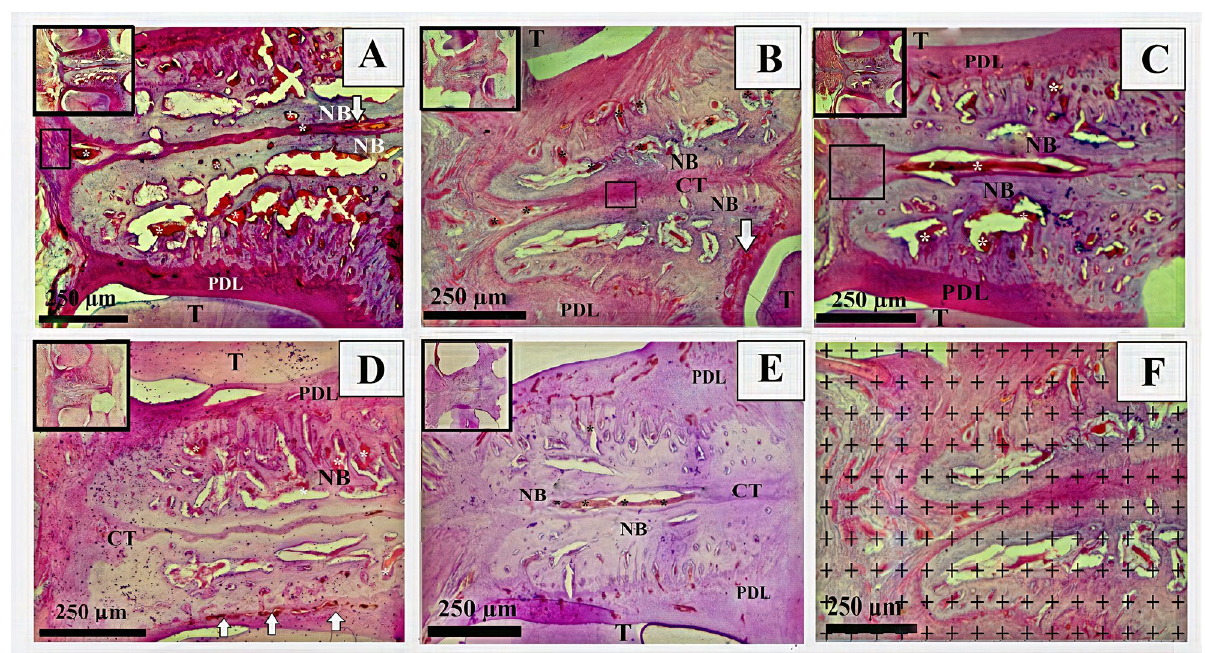
Figure 5. Histological representative light microscopic images of the groups ( A ) F2, ( B ) F1, ( C ) U2, ( D ) U1, ( E ): C and the point counting grid for Cavalieri volume estimation ( F ). NB: new bone; white arrows: new capillaries; CT connective tissue; small squares: infiltration areas; PDL periodontal ligament; T: tooth; larger squares: panoramic view of distracted areas (hematoxylin & eosin